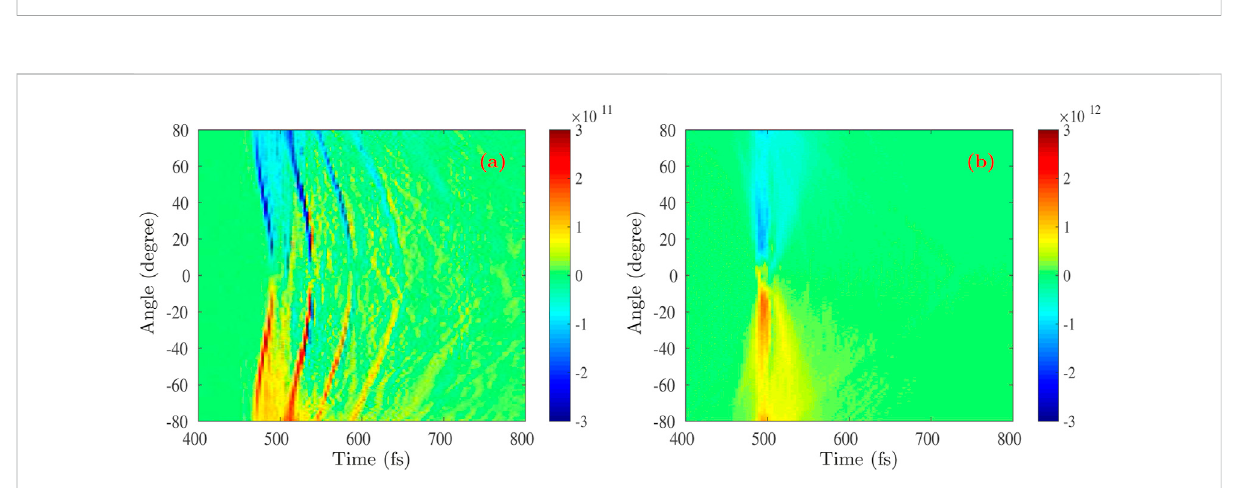
FIGURE 1 The initial sketch of the T-type target and the radiated electromagnetic fi eld which is generated behind the target by the coherent transition radiation (CTR) mechanism. The black dashed line represents the semi-circle which is used to collect the radiated electromagnetic fi eld.